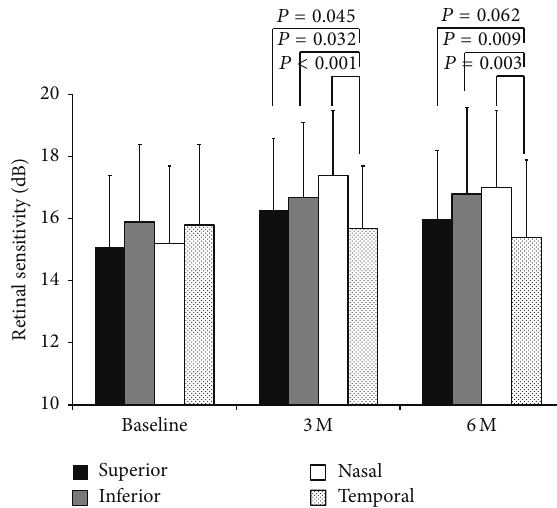
Figure 3: Regional changes of retinal sensitivity after the MH surgery. At 3 and 6 months postoperatively, the difference of retinal sensitivity between four quadrants was significant ( 𝑃 = 0.003 and 𝑃 = 0.006 , Kruskal-Wallis test). The retinal sensitivity at temporal quadrant was lower than those at other quadrants at 3 and 6 months (versus superior, 𝑃 = 0.045 and 𝑃 = 0.062 ; versus inferior, 𝑃 = 0.032 and 𝑃 = 0.009 ; versus nasal, 𝑃 < 0.001 and 𝑃 = 0.003 , Mann- Whitney